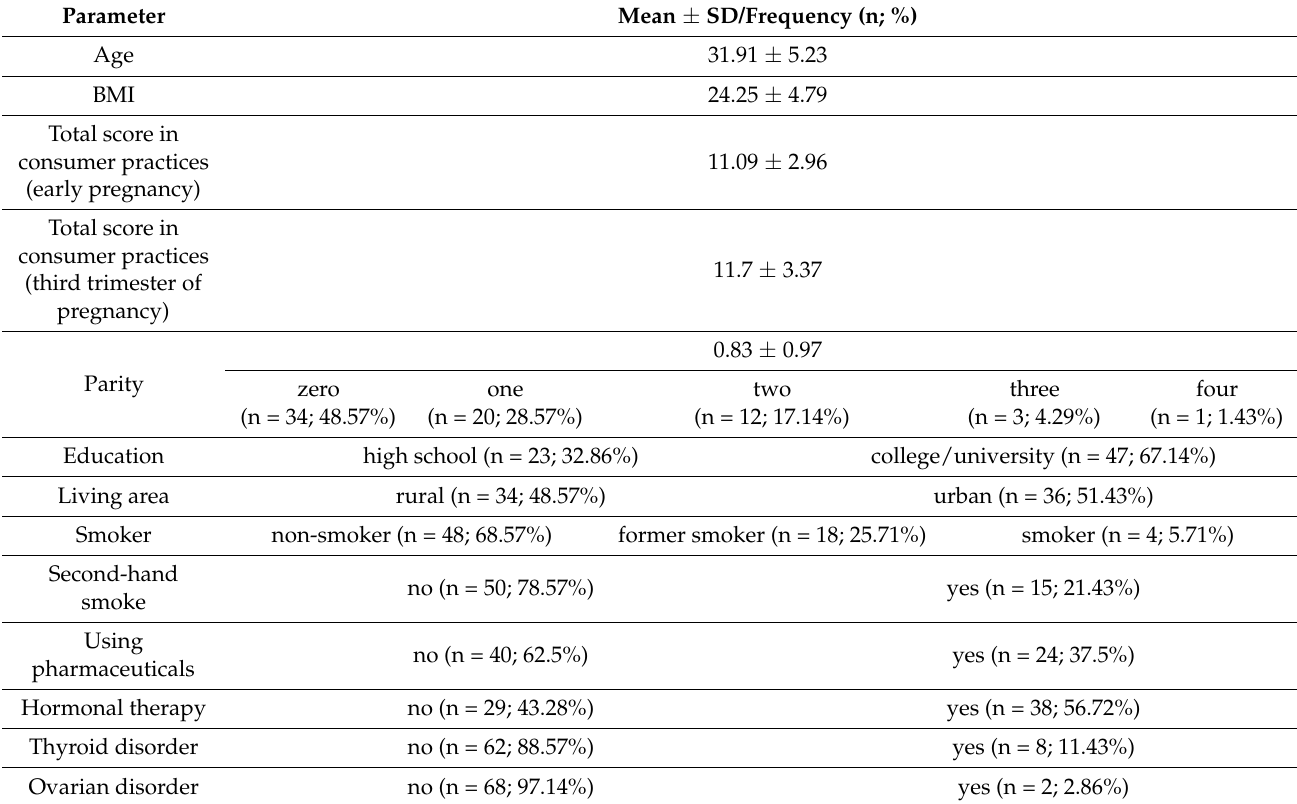
Table 2. Characteristics of mothers of our